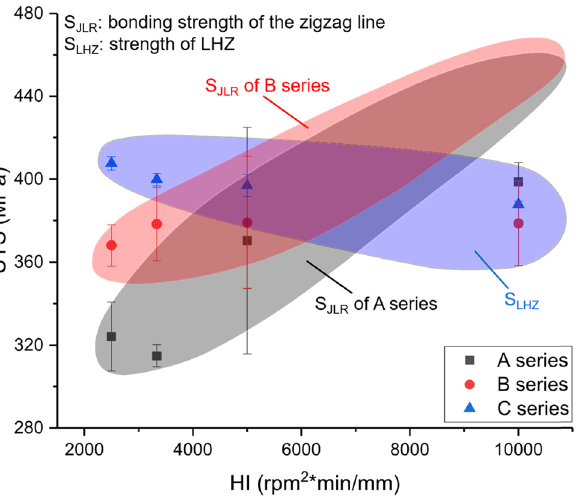
Figure 14: Schematic diagram of the general trend of S JLR and S LHZ with the change of heat input ( HI )